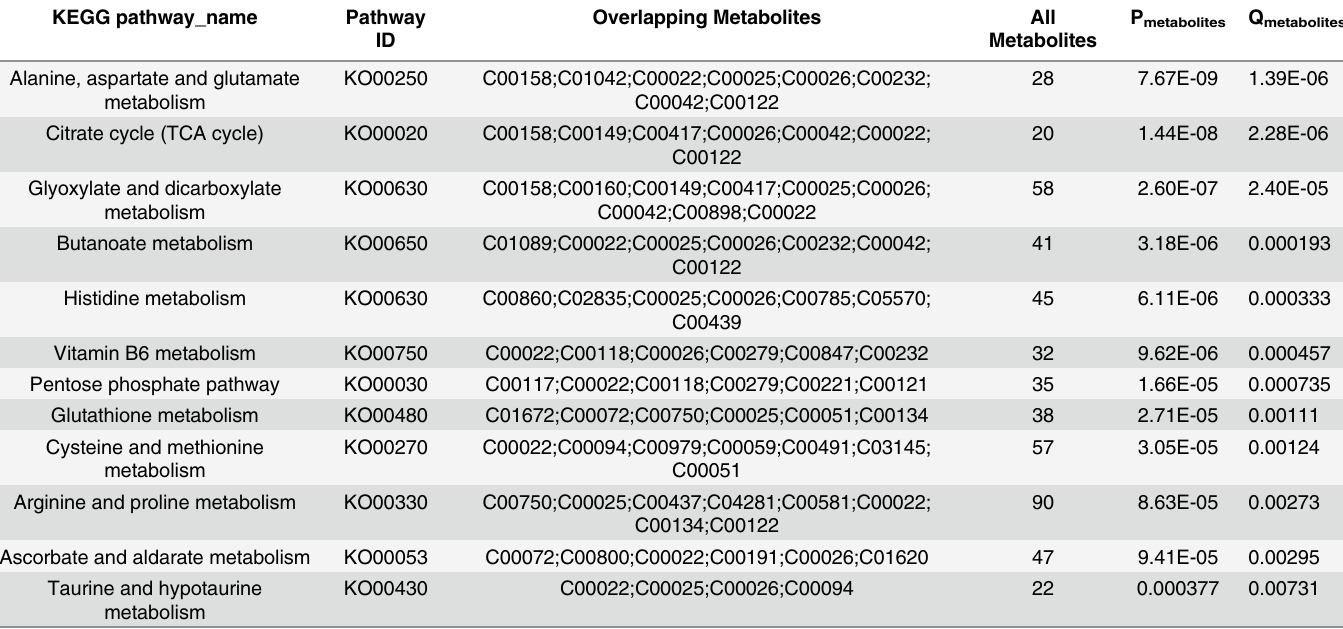
Table 1. Pathway enrichment analysis of metformin-suppressed metabolites from MKR